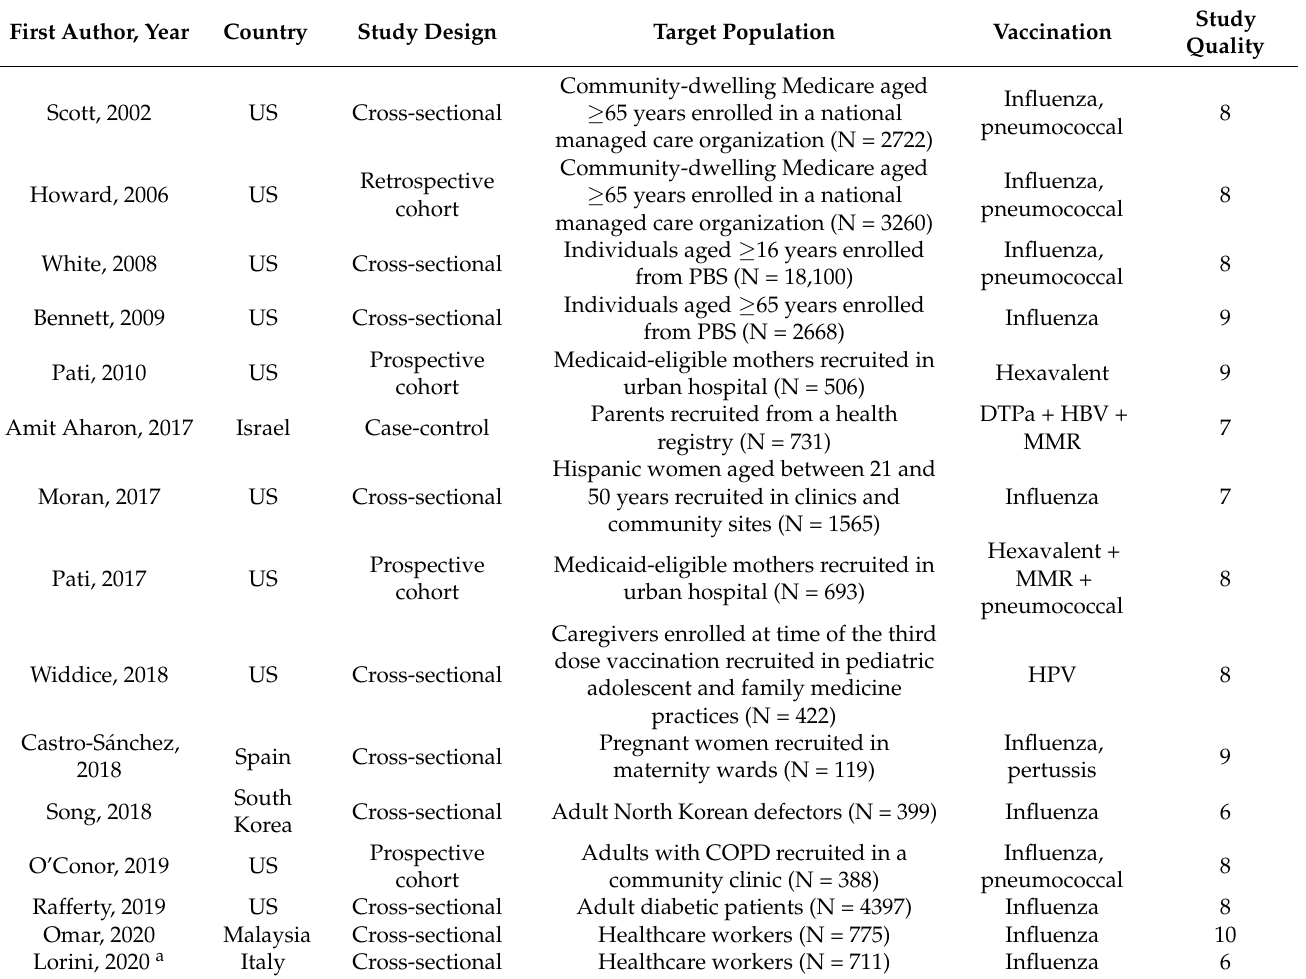
Table 2. Characteristics of the studies on vaccination status included in the systematic